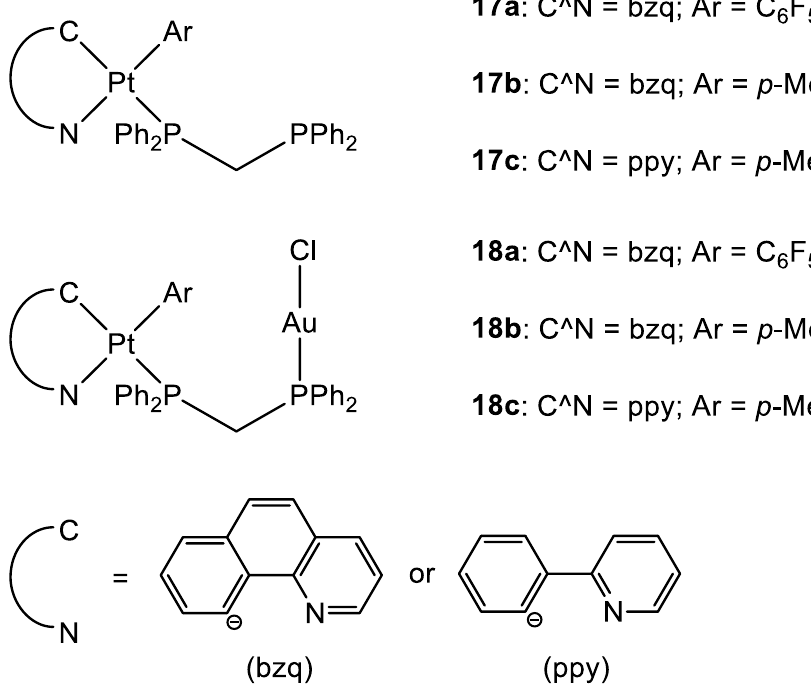
Figure 9. Molecular structure of compounds 17a – c and 18a – c .